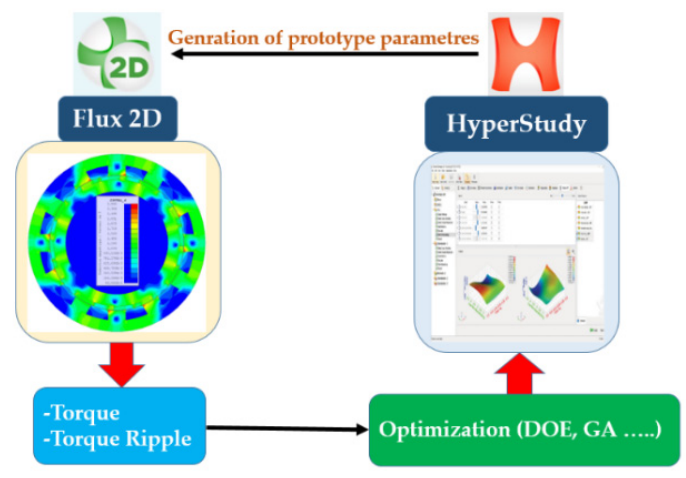
Figure 19. Optimization process with coupling between HyperStudy and Flux.